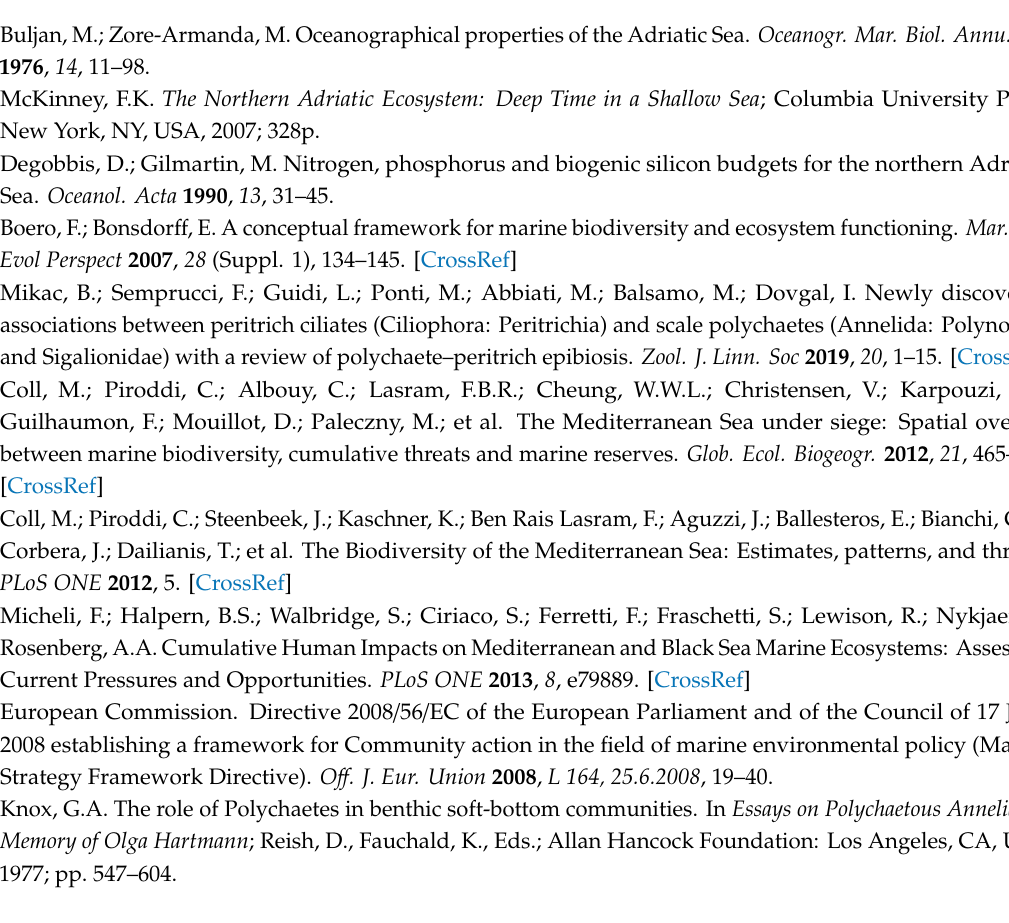
Table S1: Mean coverage (MC) (%) ( ± standard error ( ± SE), in italics) of algal species and functional-morphological groups per station and depth. Most characteristic species are marked with asterisk (*); Table S2: Mean abundance (MA) ( ± standard error ( ± SE), in italics) of Polychaete taxa per station and depth. In bold values of most abundant taxa on each station and depth; Table S3. Results of PERMANOVA pair-wise and PERMDISP analyses testing for di ff erences in abundance (N), species richness (S), Hill’s species diversity index (N1), Hill’s evenness index (N10) and structure (Stru) of polychaete assemblages: between stations, separately for each depth and between depths, separately for each station. Up, unique perms; t, t-test; P (perm), probability; P (MC), Monte Carlo probability. Significant P-values ( p < 0.05) are given in bold; Table S4. Results of SIMPER analyses (cut-o ff 70%) used to identify taxa that mostly contribute to faunal dissimilarity between stations at each depth. Species contributing to dissimilarity with more than 4% are marked with asterisk. Av.Ab = mean abundance, Diss = mean dissimilarity, Diss / SD = dissimilarity / standard deviation, Contrib% = contribution relative to single taxon, Cum% = cumulative contribution; Figure S1. Distribution of species according to their frequency in the studied samples; Figure S2. Species area accumulation curve (Sobs, Species observed) and estimator curves (Jacknife1, Jacknife2 and